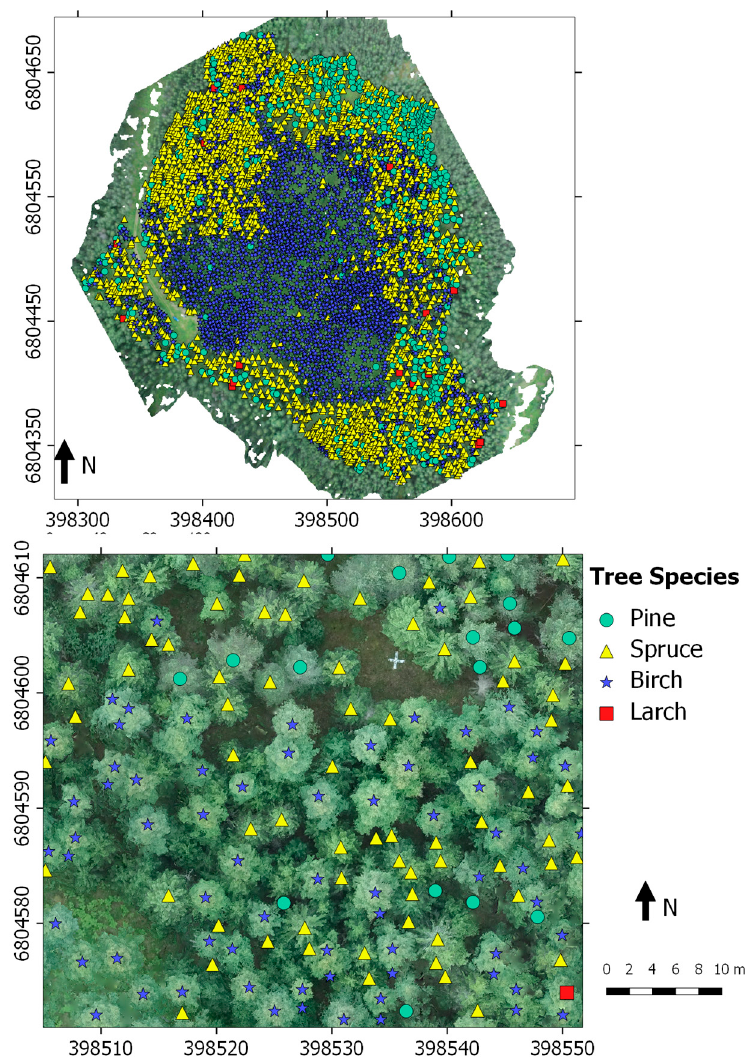
Figure 11. Example of detected and classified trees in the v05 test site. Blue stars are birches, yellow triangles are spruces, green circles are pines, and red squares are larches.